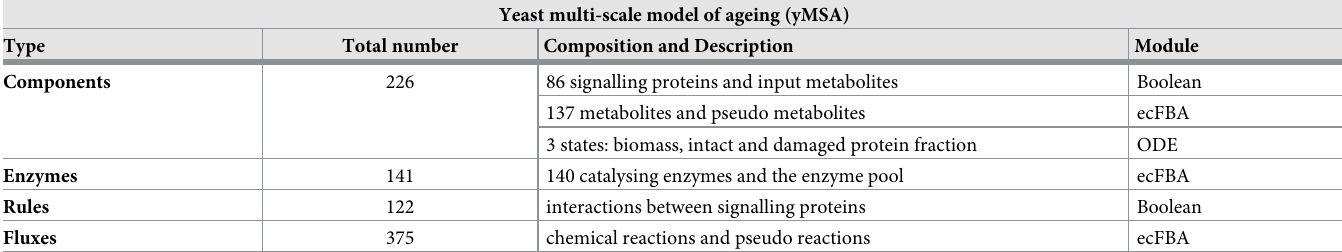
Table 1. The size of the yeast multi-scale model of ageing (yMSA) and how it is composed of three modules. Yeast multi-scale model of ageing